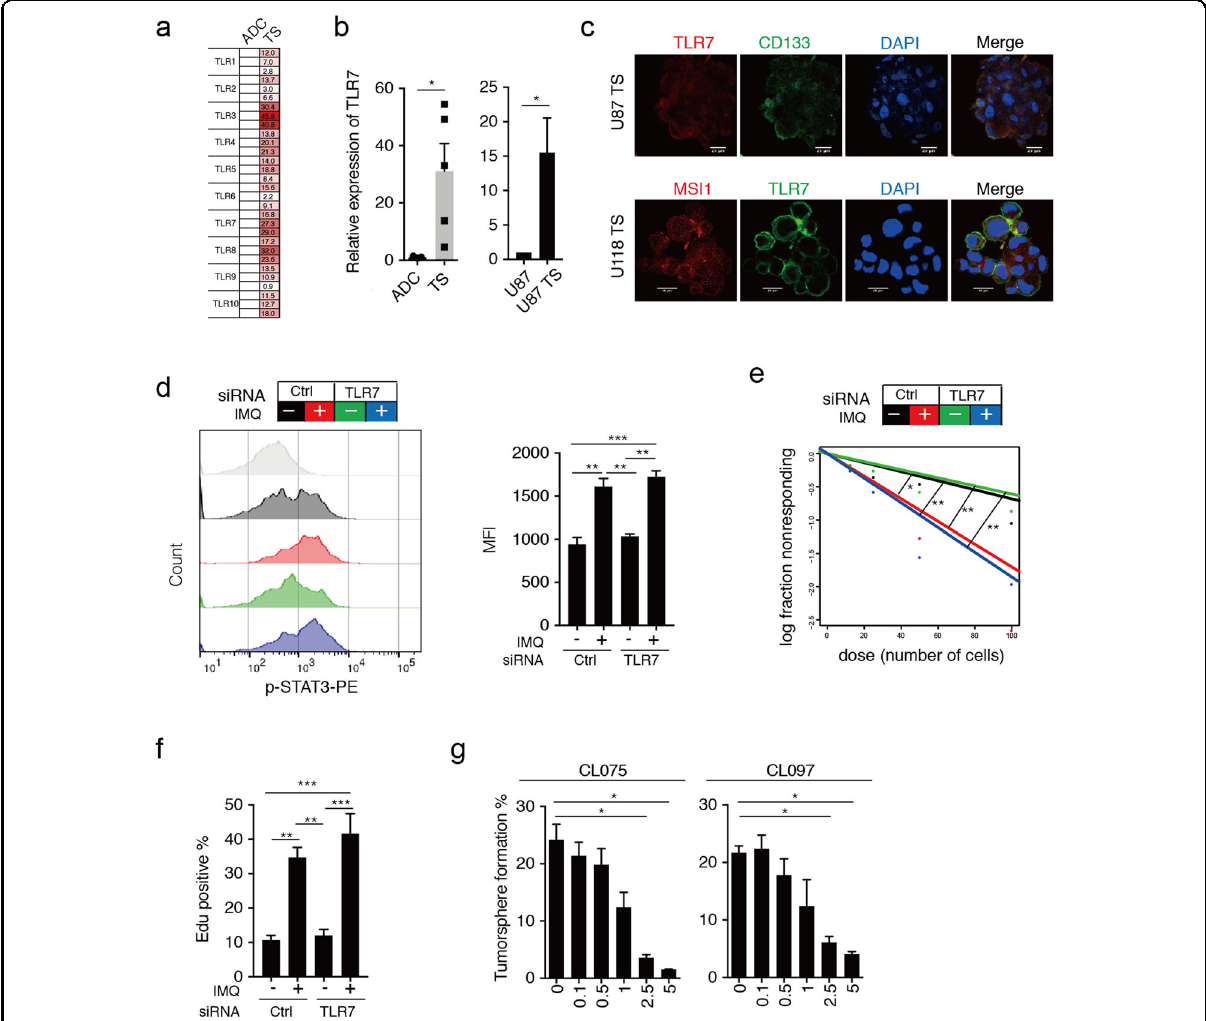
Fig. 5 Knockdown of TLR7 does not prevent the promotion of GSC-like phenotype by imiquimod. a qRT-PCR analysis of the expression of human TLR mRNA in patient-derived TS relative to their adherent differentiated counterparts (ADCs); data were normalized to those for the ADCs. The scale re fl ects the level of relative gene expression ( n = 3). b qRT-PCR analysis of TLR7 expression in patient-derived TS and ADCs (left, n = 5); qRT- PCR analysis of TLR7 expression in U87-MG and U87 TS cells (right). c Immunocytochemical analysis with anti-CD133, anti-TLR7, and anti-MSI1 in U87- MG and U118-MG cell-derived TS. Nuclei were counterstained with DAPI. Scale bar = 20 μ m. d Flow cytometric analysis of the effect of TLR7 knockdown on p-STAT3 expression in G035 cells after imiquimod (IMQ) treatment. e Extreme limiting dilution assay to examine the effect of TLR7 knockdown on the induction of sphere formation by U87 TS cells after IMQ treatment ( n = 12). * P < 0.05, ** P < 0.005; likelihood ratio test. f The percentage of dividing U87 TS cells after treatment with IMQ as well as TLR7 knockdown as determined by EdU incorporation assay. g Bar chart representing the percentage of sphere-forming G035 cells after incubation with different concentrations of CL075 and CL097 for 14 days in the absence of growth factors. Values in b , d , f , and g represent mean ± s.e.m. * P < 0.05, ** P < 0.005, *** P < 0.0005. Unpaired t test ( b , g ); one-way ANOVA with Tukey ’ s multiple comparison test ( d , f